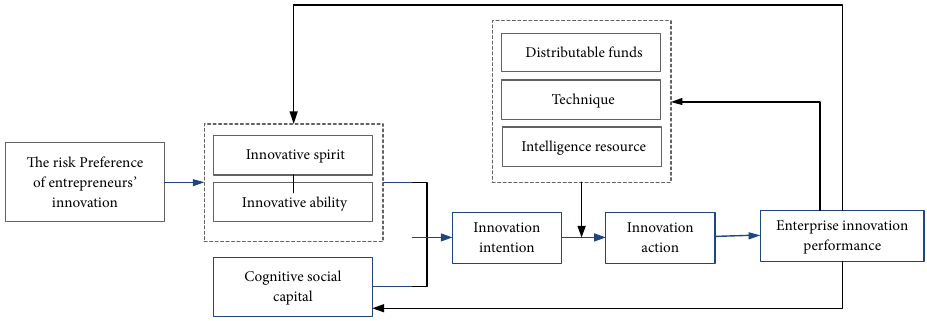
Figure 1. Context and behavior model of new generation entrepreneur